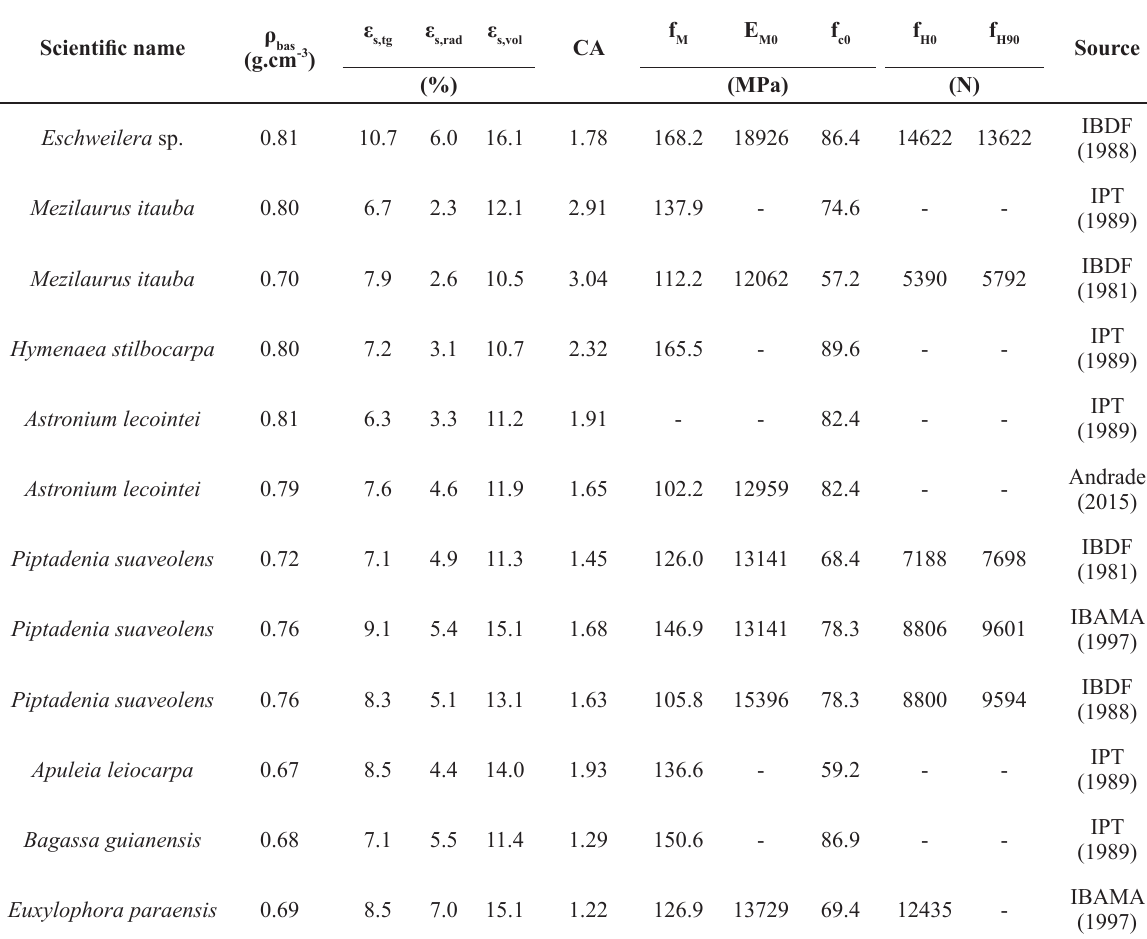
Mean values of physical and mechanical properties of woods with similar density values to those studied in this study.